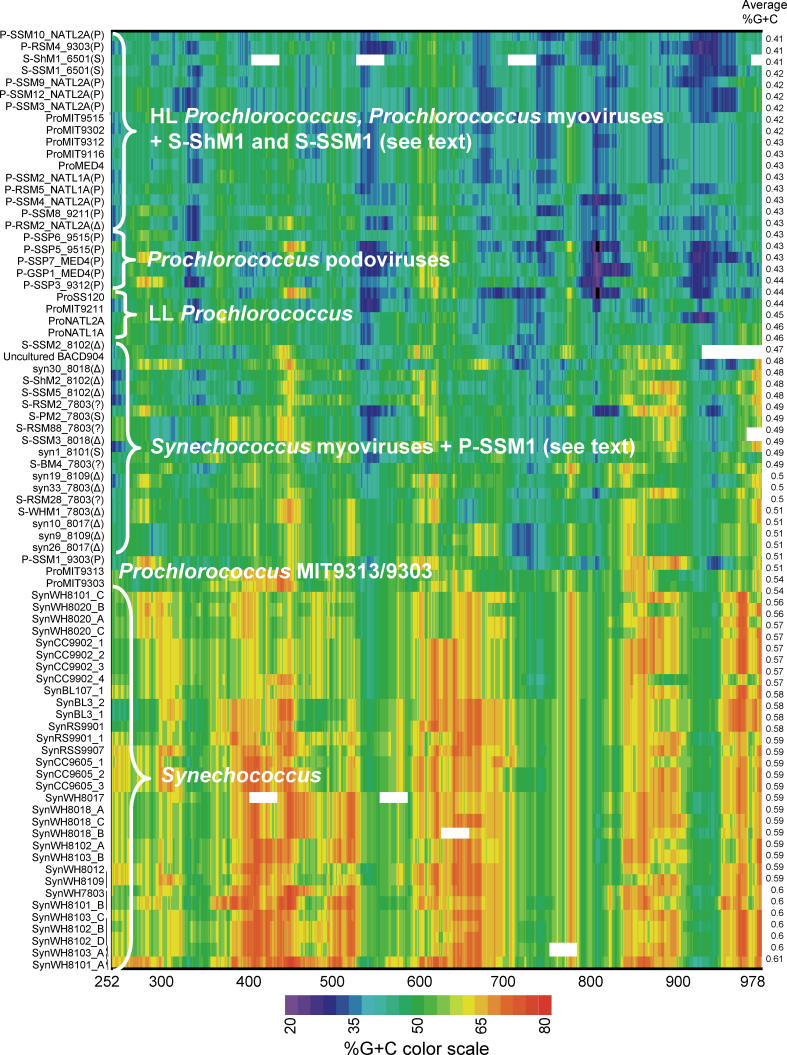
Visualization of %G+C Content across the
psbA Gene
Colors represent the averaged %G+C in sliding windows along the length of the gene (20%–80%); white regions represent windows that included ambiguous bases in which %G+C could not be calculated for that region. The average %G+C content of the amplified sequence is tabulated on the right side of the figure. Phages are listed by phage name followed by their original host. Phages that are known to infect both
Prochlorococcus and
Synechococcus hosts are indicated with a “Δ”; those that infect only one genus or the other have no marker, while those that are unknown are designated with a “?”. Host names are prefaced with Syn or Pro for
Synechococcus and
Prochlorococcus hosts, respectively. Scale indicates nucleotide positions relative to the
psbA gene sequence in
Thermosynechococcus.